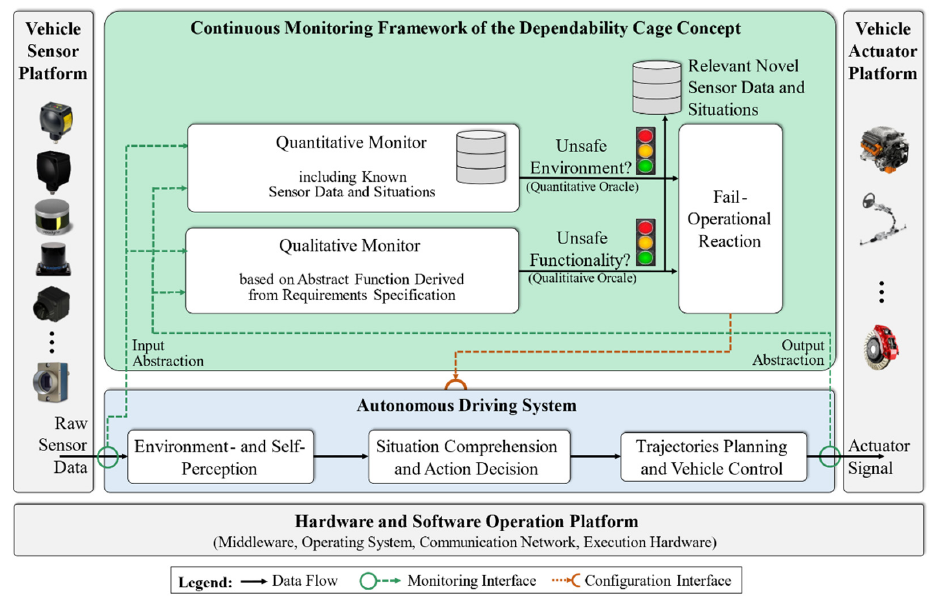
Figure 3. Continuous monitoring architecture as a part of dependability cage.